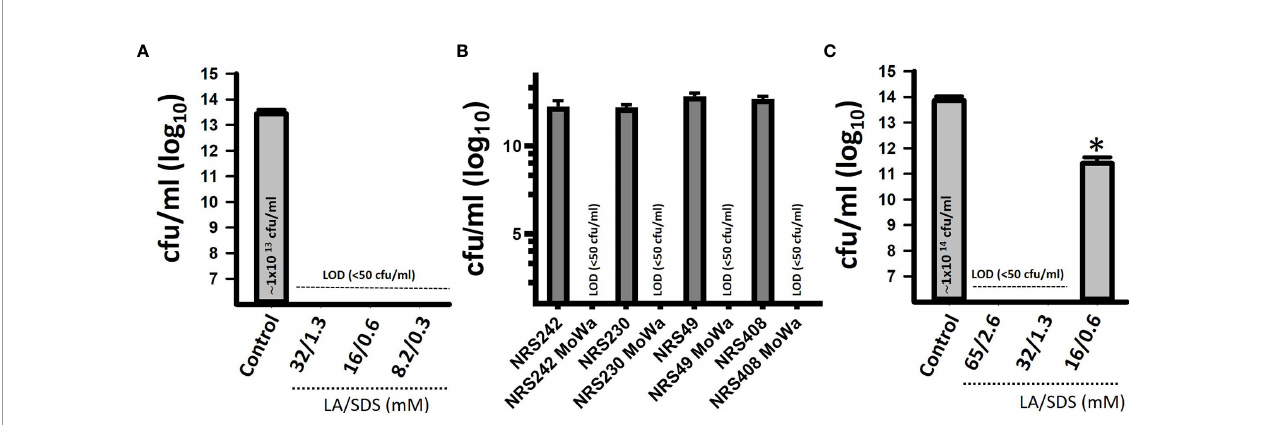
FIGURE 1 | MoWa eradicates planktonic and bio fi lm cultures of MRSA strains. Bacteria were inoculated (~1 × 10 6 cfu/ml) in 24-well plates containing BHI broth and left untreated (control) or treated with the indicated dose of a mixture of levulinic acid (LA) and SDS (MoWa). (A) Treated and untreated NRSA384 cultures were incubated at 37°C for 24 h and then planktonic staphylococci were harvested, diluted and plated to obtain the density (cfu/ml). (B) The indicated MRSA or MSSA strain was left untreated or challenged with MoWa 8.2/0.3 mM. (C) Strain NRS384 was inoculated as above and incubated from 24 h. Planktonic staphylococci were then removed, and bio fi lms were washed and added with BHI broth. These bio fi lms were treated with the indicated dose of a mixture of levulinic acid (LA) and SDS for 24 h and then bio fi lms were harvested to obtain colony counts (cfu/ml). Error bars represent the standard errors of the means calculated using data from at least three independent experiments. * p <0.05 compared to control. LOD, limit of detection. In panels (A, C) the median density is shown inside the bar of the untreated